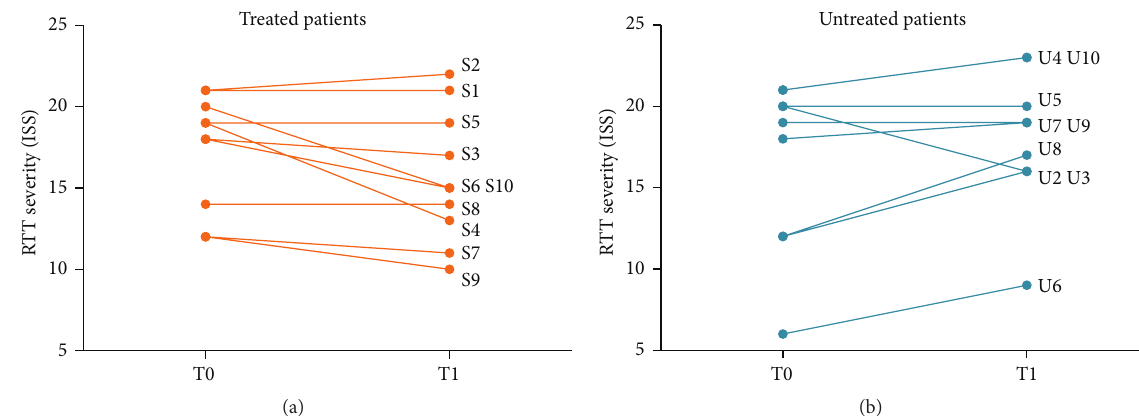
Figure 1: ISS before and after treatment for (a) IGF1 treated and (b) untreated patients. The Mean change in ISS in IGF1 treated versus untreatedpatients( 𝑝 = 0.0106 ,Mann-Whitney 𝑈 test,two-tailed).ThechangeinISSforthetreatedgroupwasshortofsignificance( 𝑝 = 0.052 , Wilcoxon Signed Ranks Test, two-tailed). ISS: International Scoring System. S1–10: treated patients 1–10; U2–10: untreated patients 1–10.